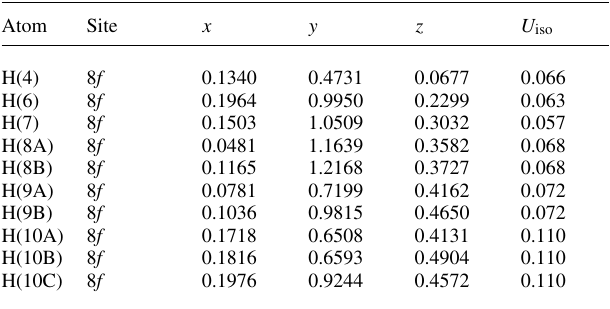
Table 2. Atomic coordinates and displacement parameters (in Å 2 )